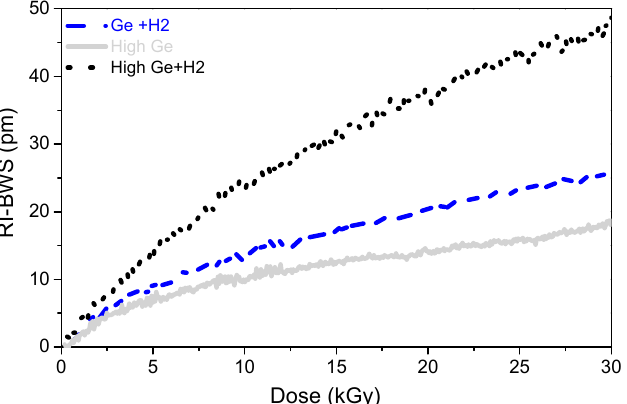
with the same reflectivity, written with a UV laser at 244 nm through a PM in two H 2 -loaded Ge-doped fibers (at 160 bars and RT, for 10 days): a standard Corning SMF28 (5 wt%) and wt%) and a photosensitive (>15 wt%). The two gratings were also subjected to the same a photosensitive (>15 wt%). The two gratings were also subjected to the same thermal thermal treatment (at 60 °C for 24 h) to highlight only the Ge-content influence. treatment (at 60 ◦ C for 24 h) to highlight only the Ge-content influence.